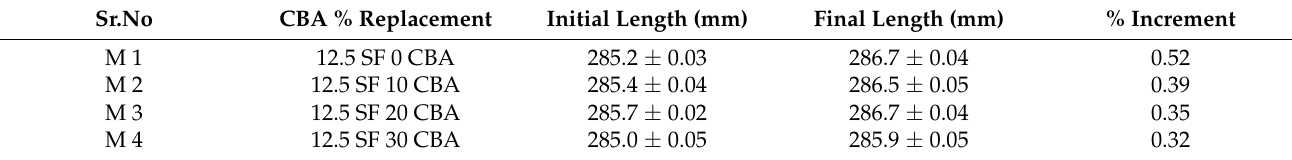
Table 4. Sulfate Attack of 28-Days in sodium sulfate solution (Na 2 SO 4